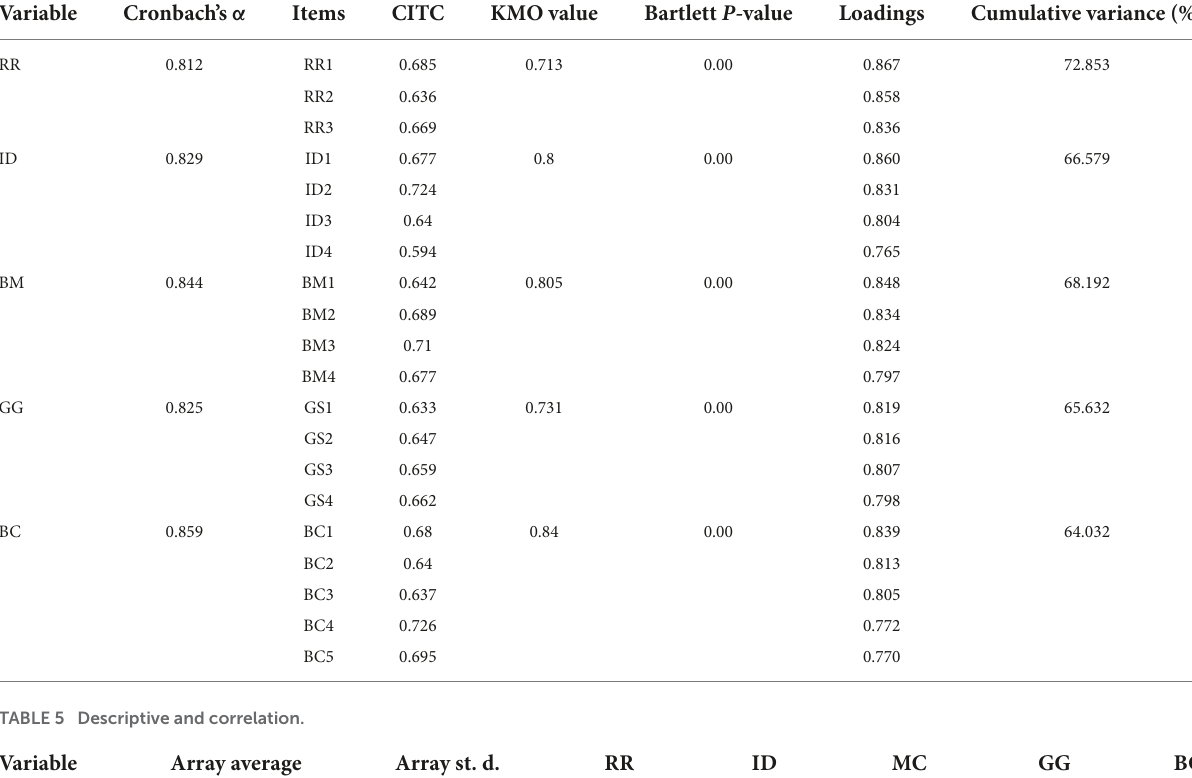
TABLE 4 Test results of model reliability and validity.